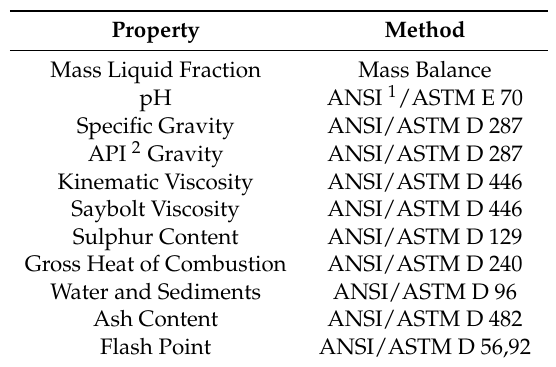
Table 2. American Society for Testing and Materials procedures (ASTM) analysis performed on the liquid fraction obtained from the pyrolysis of vulcanized rubber from waste